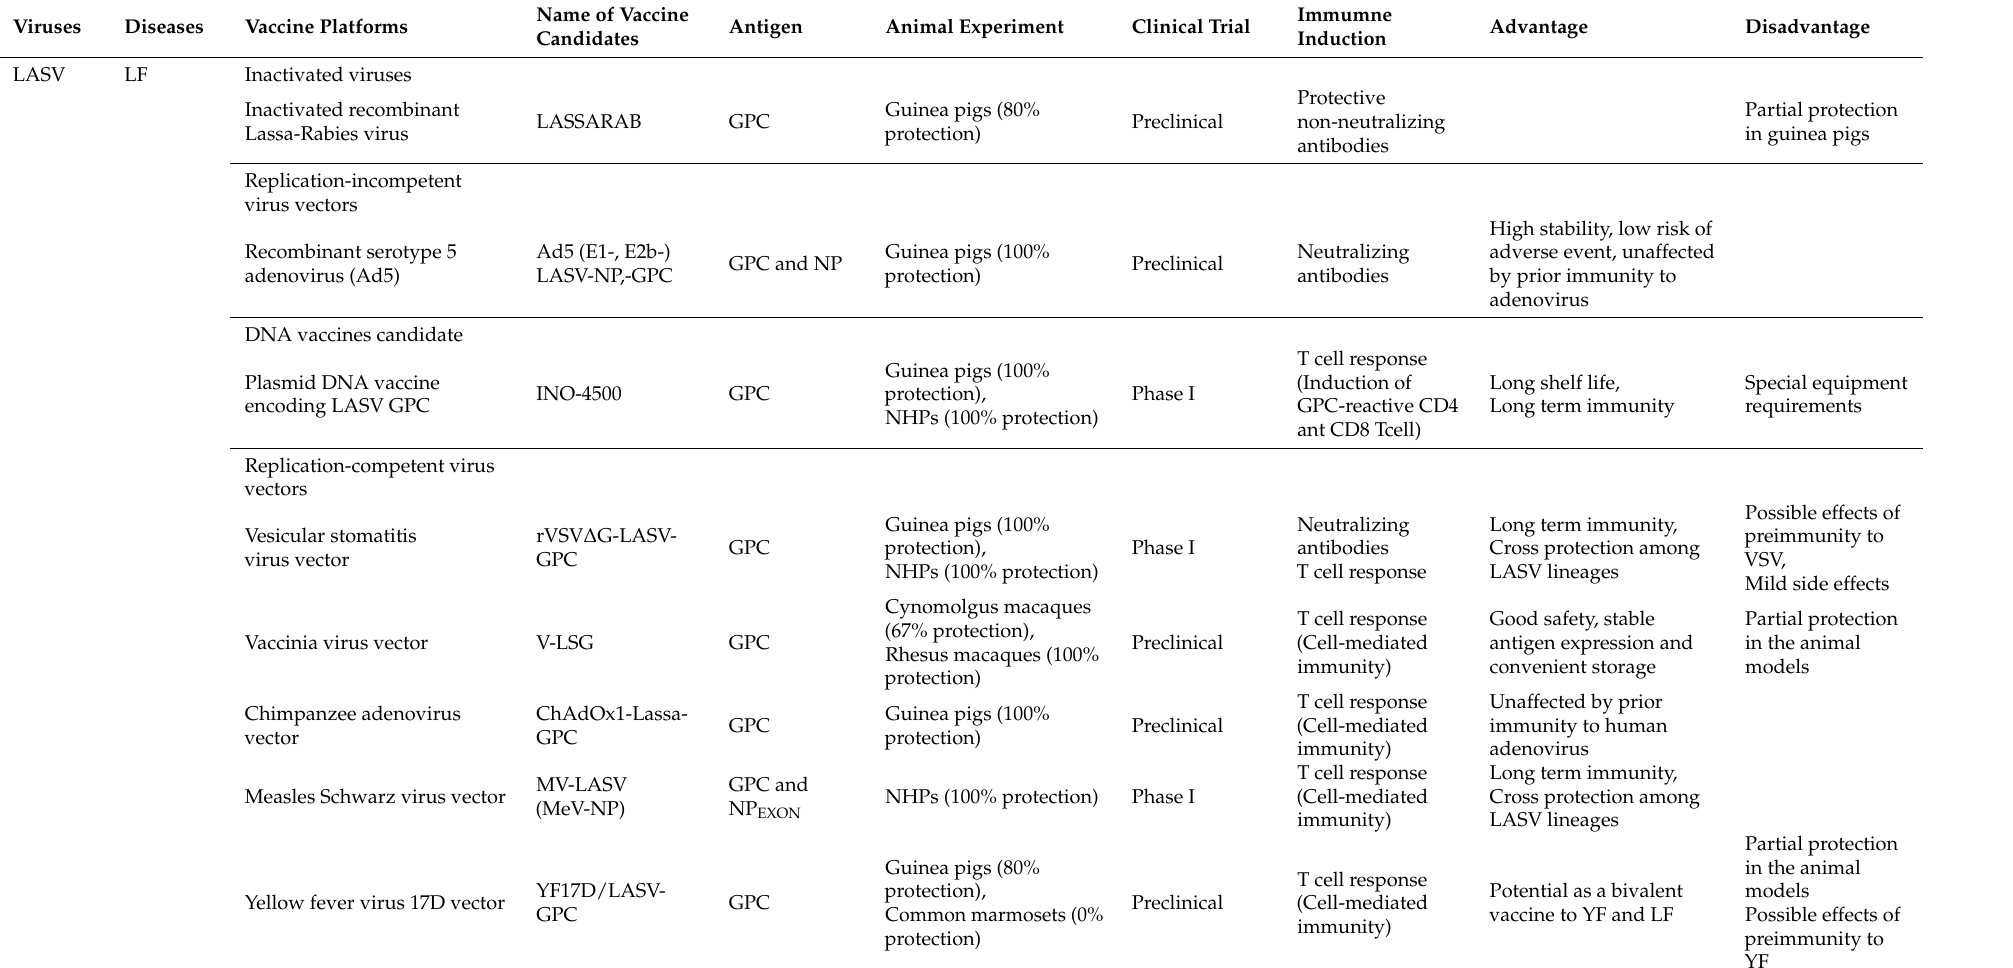
Table 1. Summary of vaccine candidates for OW arenavirus